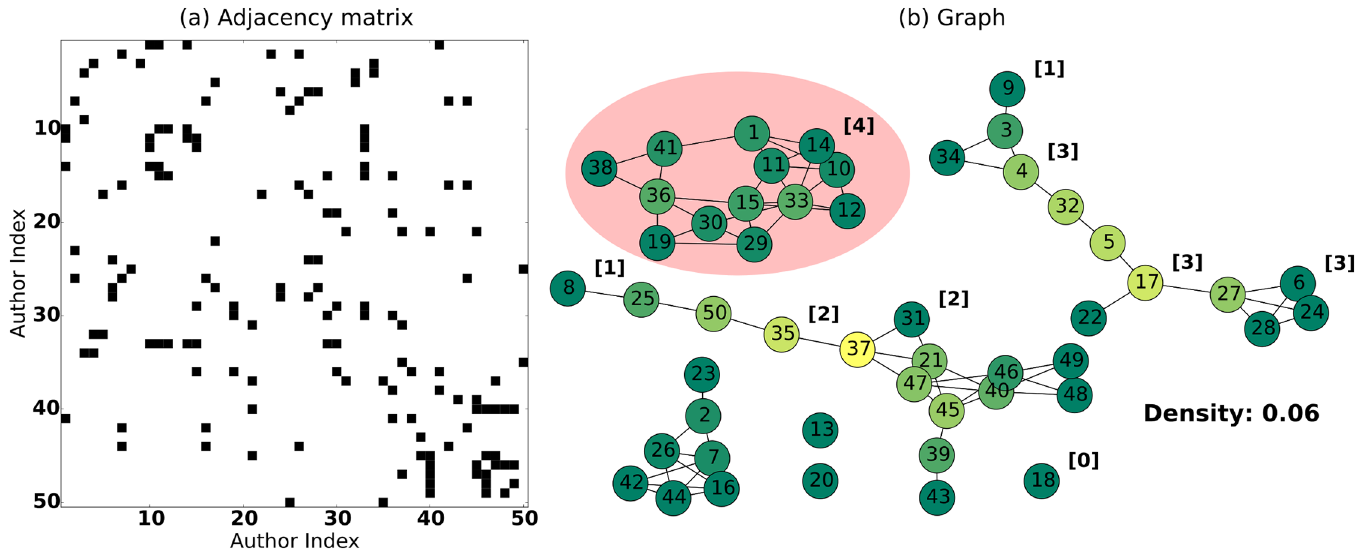
Fig 1. (a) Example of an Adjacency Matrix, the generic data format used in Social Network Analysis. This example represents a network of authors. The rows and columns of the matrix represent 50 different authors. Black squares indicate the author in the row and column have at least co-authored one paper together. Note that the matrix is symmetrical. (b) Graphical representation of the adjacency matrix in panel a. This visualization reveals that the network consists of seven components, one of which has been circled. The colours of the nodes are determined by their betweenness centrality. In this network, author 37 has the highest betweenness centrality. The degree of selected author nodes is indicated using a number in brackets. The density of this network is about 0.06 (i.e., the average value of the adjacency matrix, omitting the diagonal).